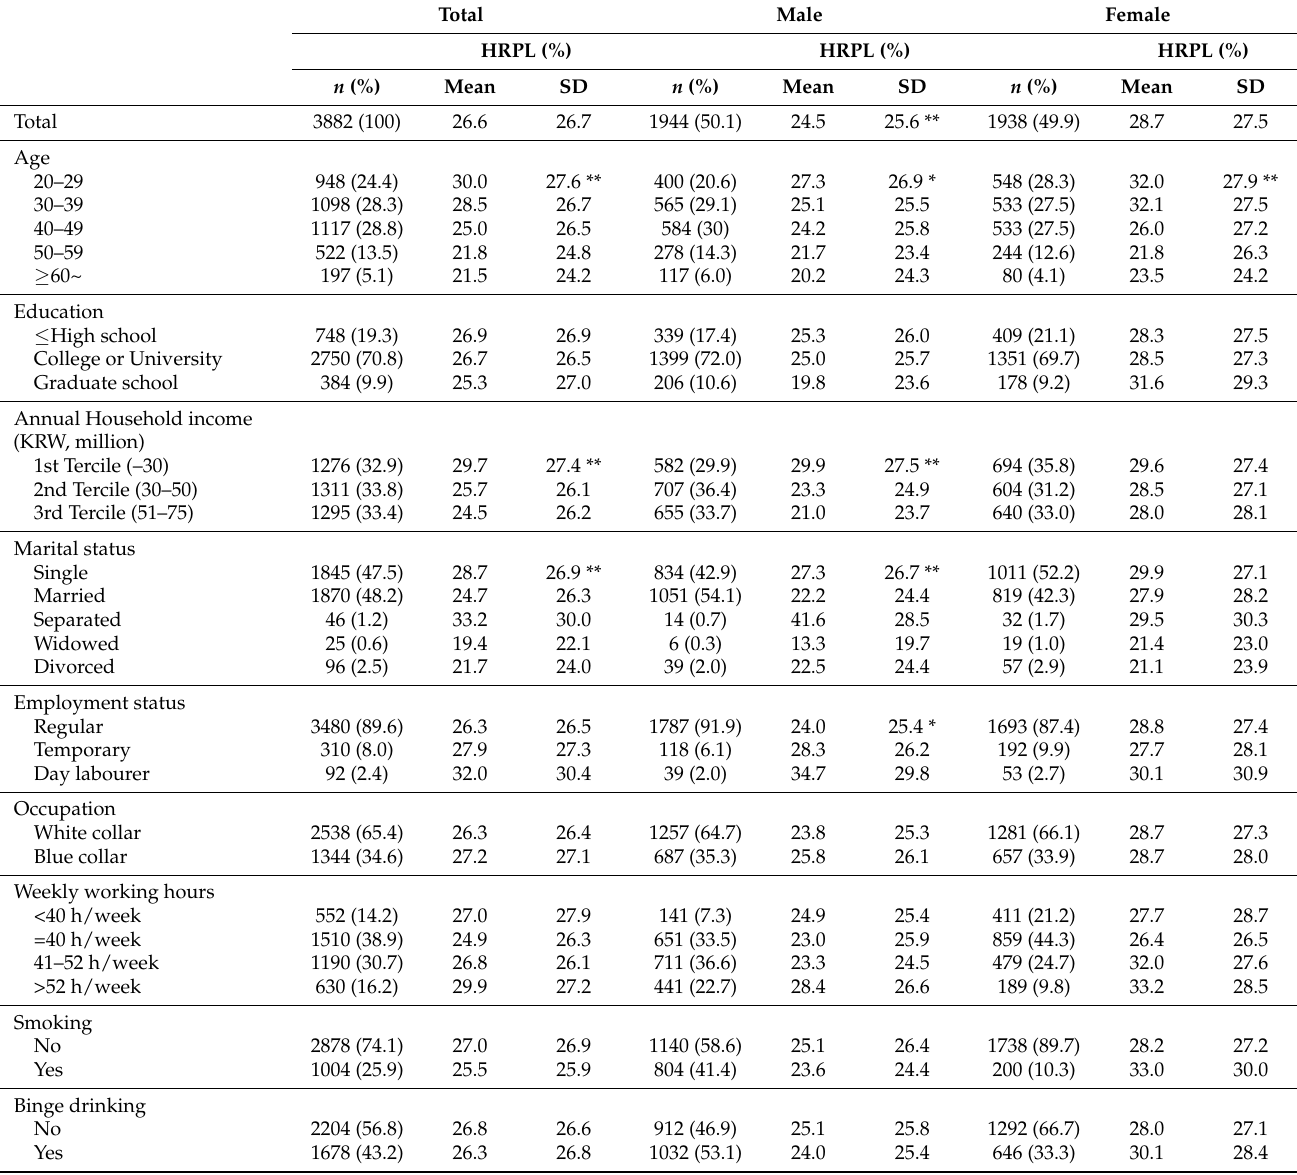
Table 1. Demographic characteristics and health-related productivity loss (%) of the study participants.